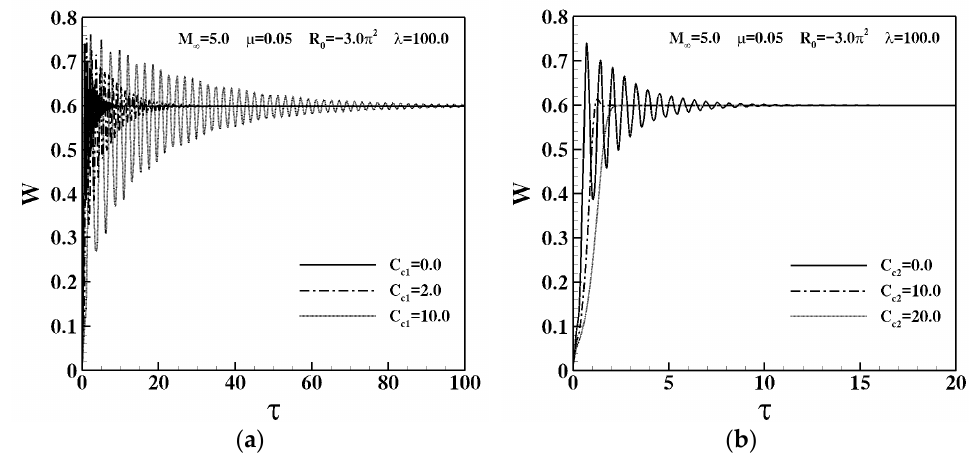
Figure 16. The convergence process of the buckling response under different inertial and viscous resistances: ( a ) inertial resistances; ( b ) viscous resistances.